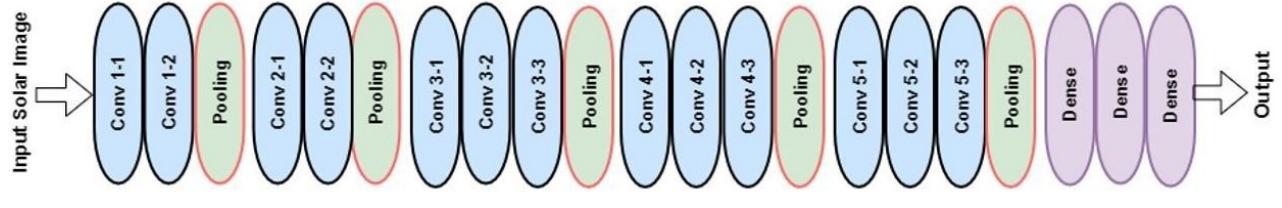
Figure 7. Architecture of VGG16 model